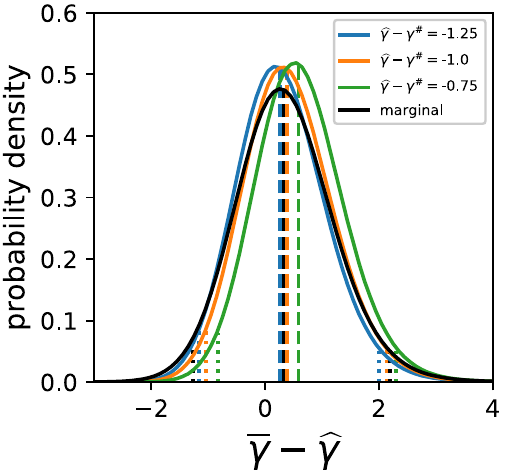
Figure 9. Examples of conditional probability density function q 3 ( ·| u , v ) (coloured) and marginal probability distribution q 1 ( · ) (black), along with median (dashed lines) and 95% confidence intervals (dotted lines). The conditional probabilities are for u = 2 ; v = − 1.25, − 1, − 0.75 .